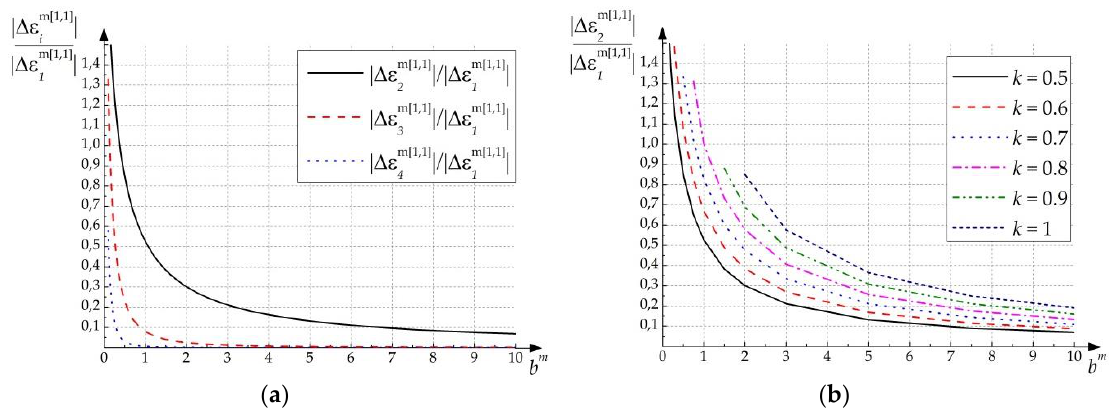
Figure 4. Calculated ratios: ( a ) of the first and higher harmonics depending on the parameter b m (for k = 0,5); ( b ) of the first and second harmonics for different k .